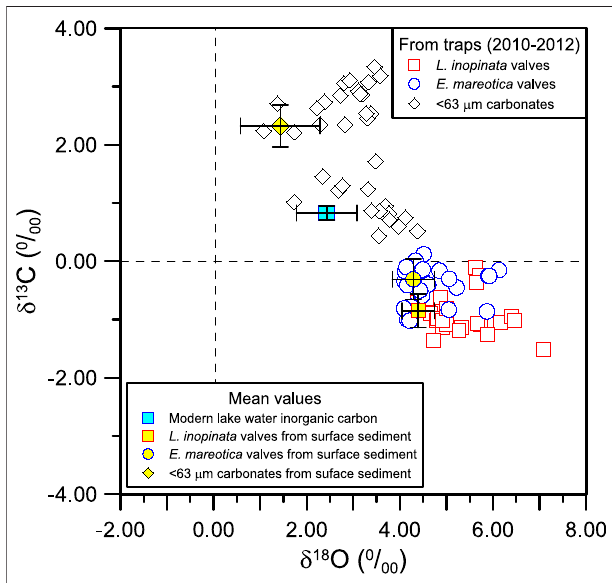
FIGURE 7 | The relationship of δ 18 O and δ 13 C among total inorganic carboninlakewater,adultostracodshells( L.inopinata and E.mareotica ),and < 63 μ m carbonates from the sediment trap and surface sediment in Lake Qinghai. The data of the core QING 6 are cited from Henderson et al.